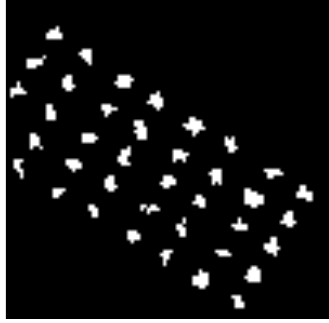
Figure 9. The real HSI